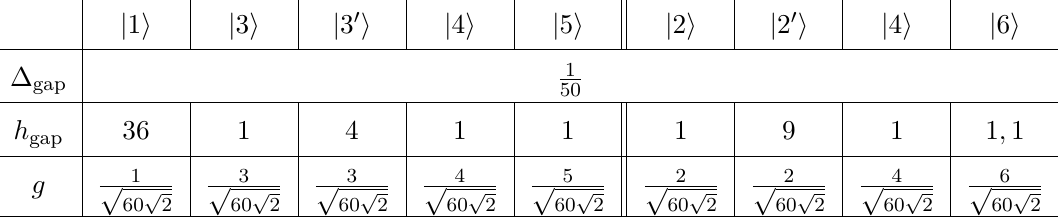
Table 5. Stable rational branes in the SU(2) 1 /A 5 orbifold CFT. The notations are parallel to that in table